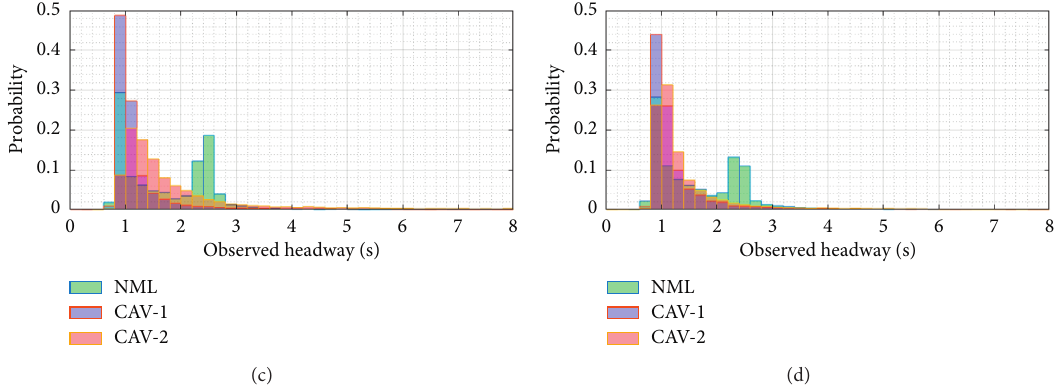
Figure 6: Headway distributions in the left-most lane. (a) 40% MPR. (b) 50% MPR. (c) 60% MPR. (d) 70%